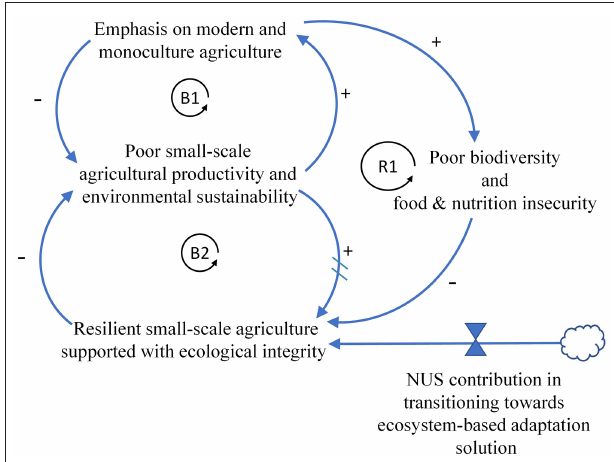
FIGURE 4 | Shifting the burden system archetype. Balancing loop B1: Illustrates how the conventional policy strategy has sought to address agricultural productivity through monoculture and agrochemical input. R1, a vicious reinforcing loop, shows that modern farming has not always proved sustainable for small-scale agriculture in the long term as biodiversity loss and food and nutrition insecurity have become persistent. Loop R1: Emphasis on modern and monoculture agriculture? Poor biodiversity and food and nutrition insecurity? Resilient small-scale agriculture supported with ecological integrity? Poor small-scale agricultural productivity and environmental sustainability? Emphasis on modern and monoculture agriculture. Loop B2: the long-term vision that seeks to address problems of small-scale farming by developing resilience and ecological integrity. NUS crops are shown to contribute to a transitioning process that encompasses ecosystem-based adaption